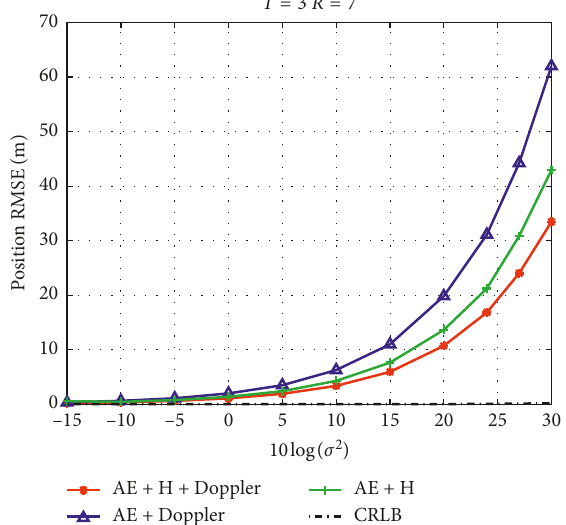
Figure 5: Comparison of the position RMSE of the proposed method with AE+Doppler, AE +H, and CRLB when T � 3, R � 7. The CRLB is close to zero, but it is going up as the noise power increases.